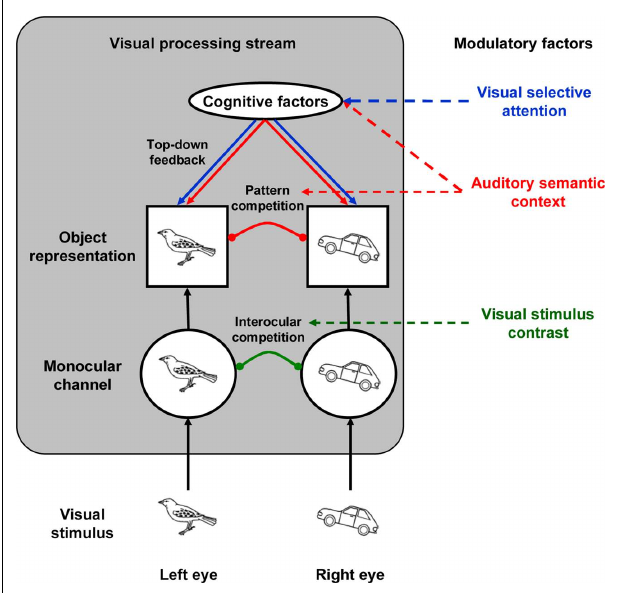
FIGURE 4 | Schematic figure of the visual processing stream in the binocular rivalry situation adopted fromTong et al. (2006). In this example, the left eye “sees” a bird while the right eye “sees” a car.The information is represented in monocular- and object-level sequentially, and two types of competition, interocular and pattern competition, occur at each level, respectively. Presumably, the visual stimulus contrast factor modulates interocular competition, whereas the visual selective attention factor modulates pattern competition via top-down feedback connections. The auditory semantic context factor may modulate the pattern competition through either crossmodal excitatory or top-down feedback